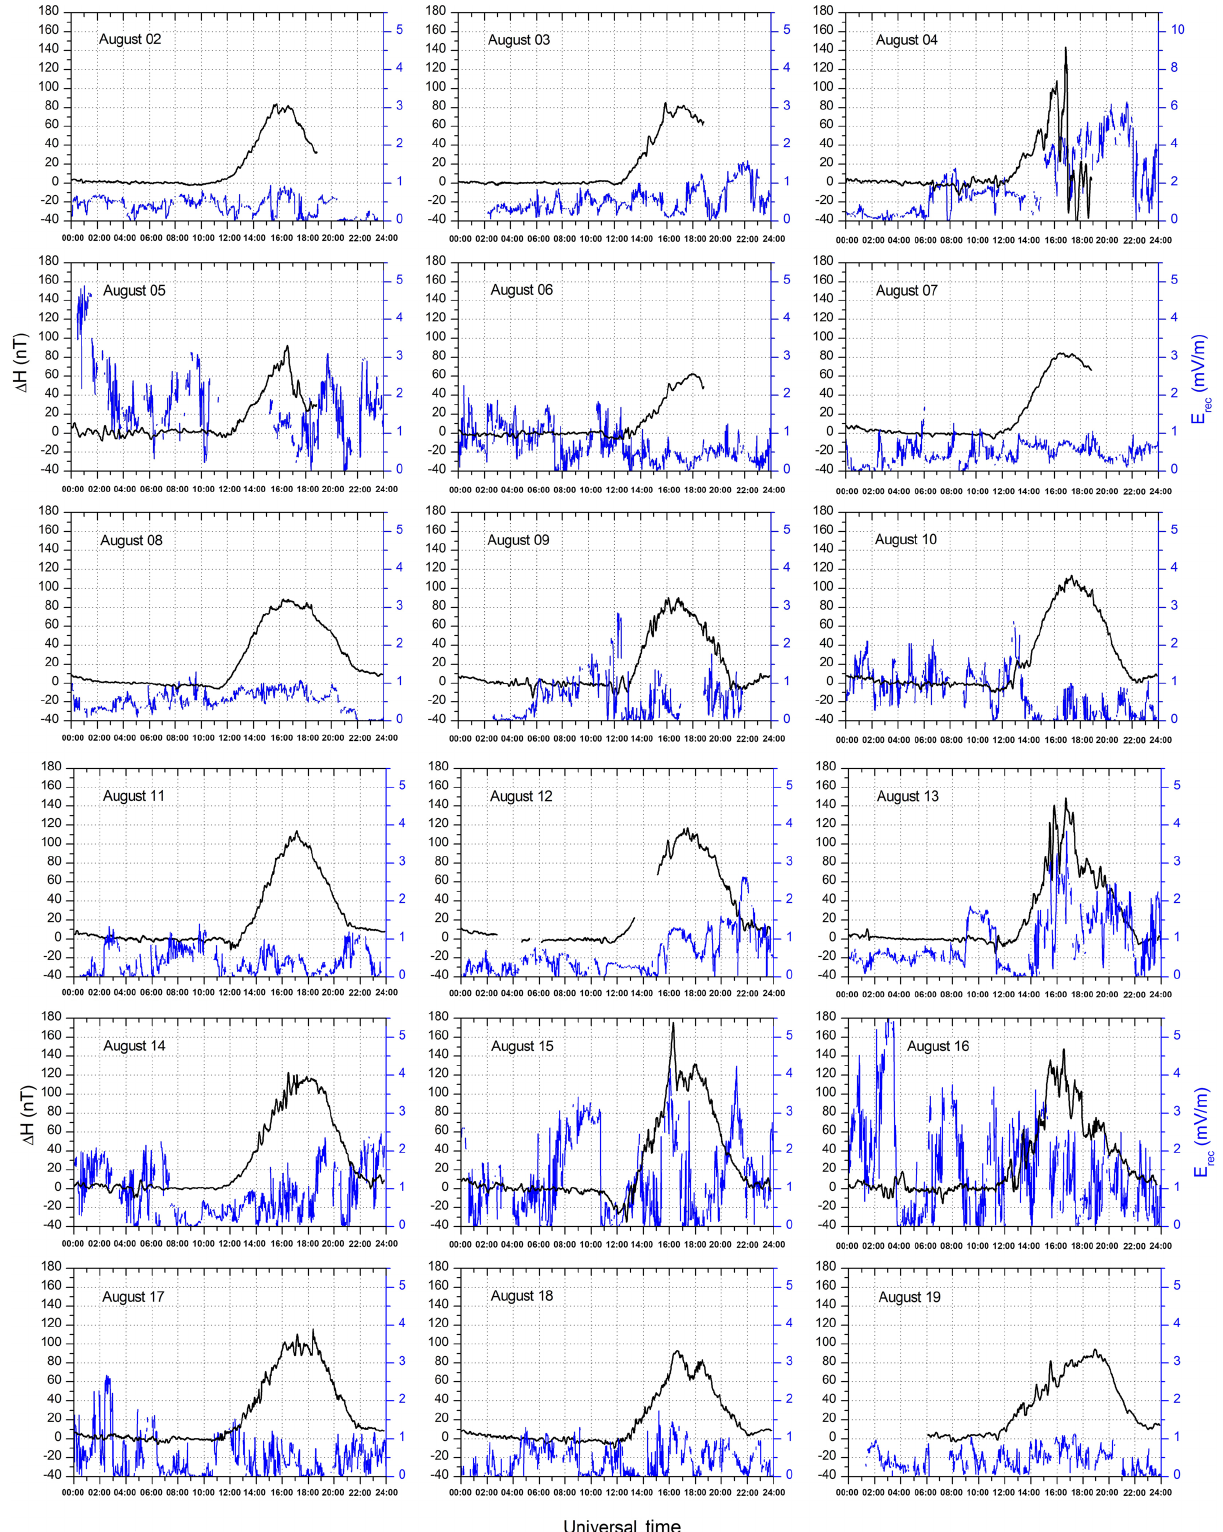
Figure 9. (cid:49) H Jicamarca–Piura (black line) and IEF E rec (blue line) from 2 to 19 August, showing the occurrence of